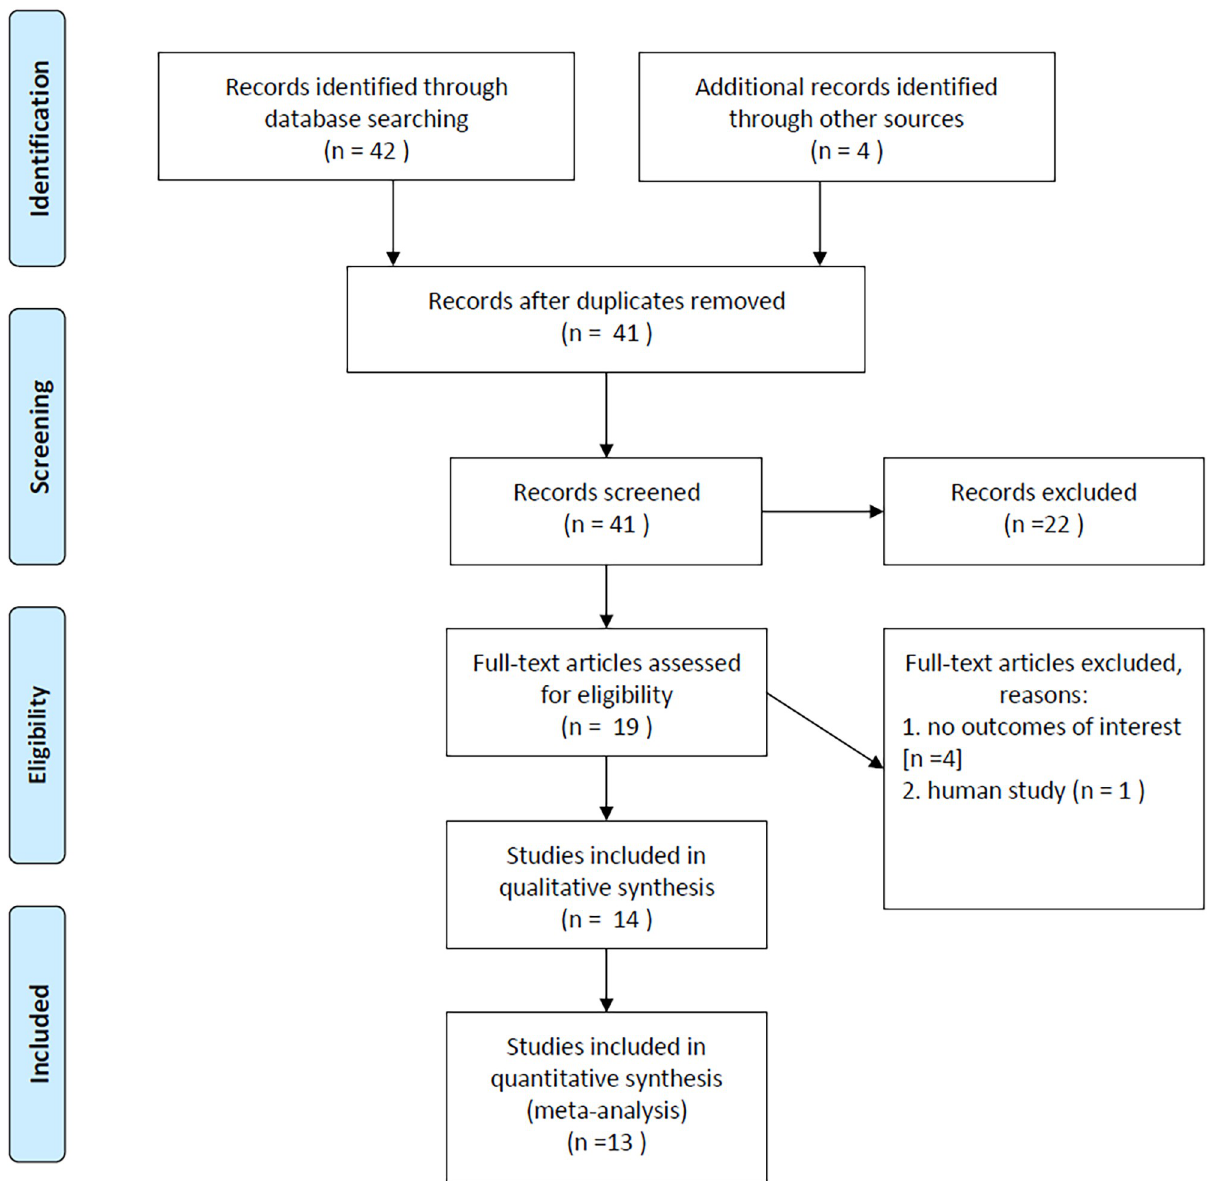
Fig 1. Flow diagram showing the number of abstracts and articles identified and evaluated during the